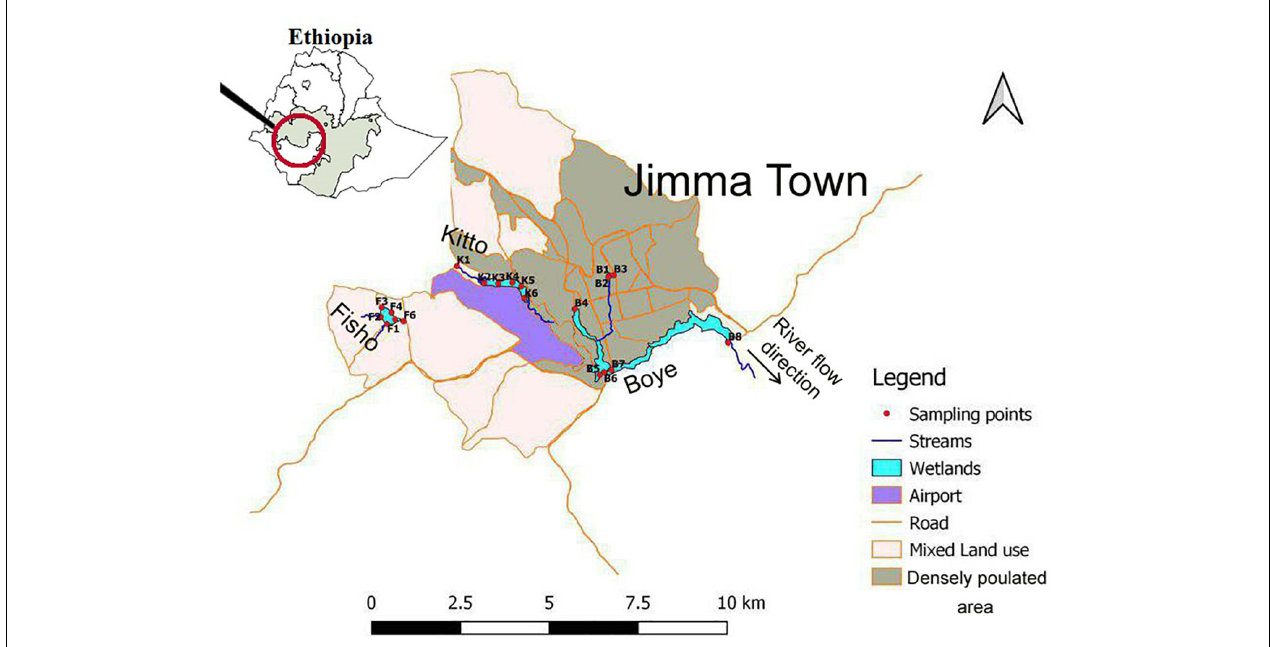
FIGURE 1 | Map of the study area including sampling locations in three natural riverine wetlands of Jimma, southwest Ethiopia (Namely; Boye (Sampling points starting with “B”), kito (that start with “K”), and fisho (points starting with “F”); and the respective incoming streams that fed those wetlands together with the outflows of the three wetlands (see Supplementary Table S1 for the site code descriptions). The indicated flow direction represents all the three wetlands in the study map.